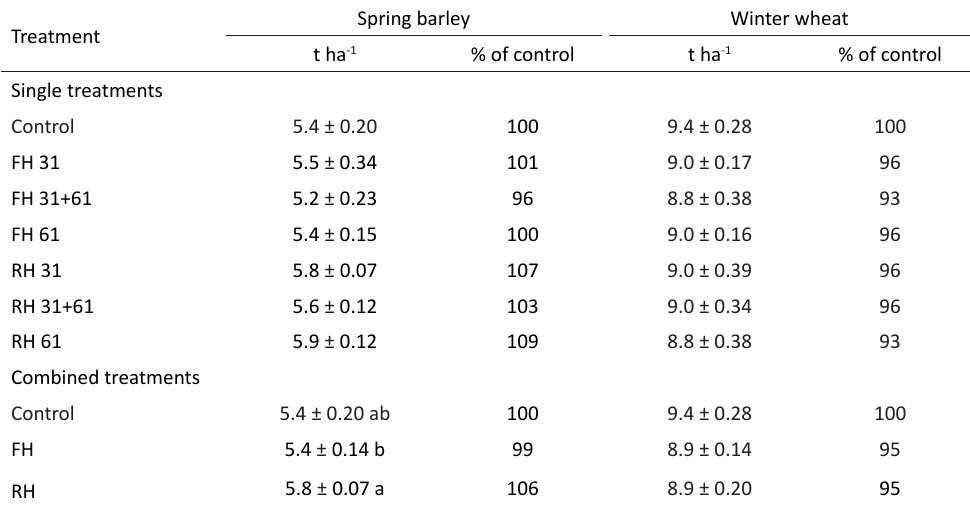
Table 7. Effect of protein hydrolysates on yield of spring barley and winter wheat in the field experiment Spring barley Winter wheat Treatment